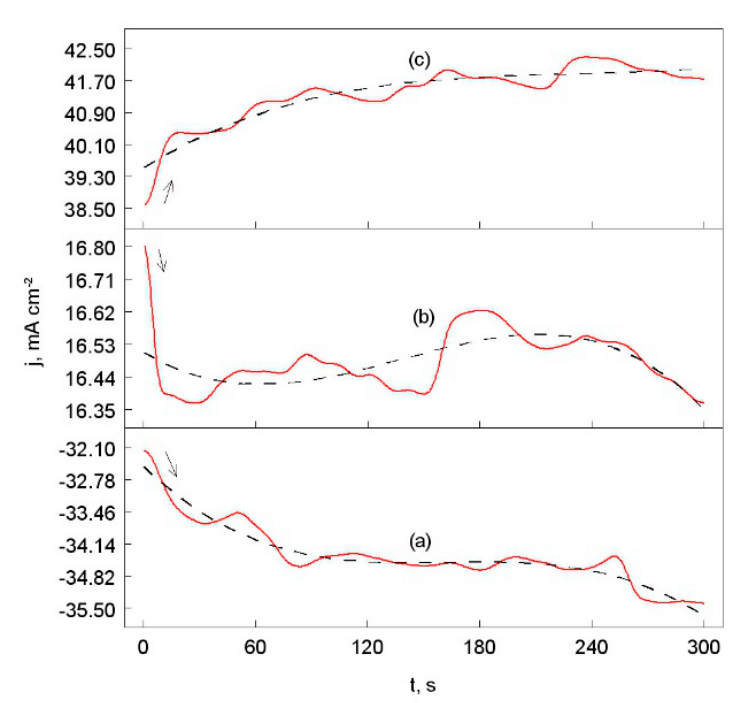
Figure 10. Chronoamperometric curves of the Al/Cu alloy after heat treatment at 600 °C, obtained for: ( a ) − 950 mV, ( b ) − 480 mV and ( c ) − 300 mV vs. SCE. Solution contained 1.2 M Cl − , pH 1.5 (dashed lines refer to the average current density values).